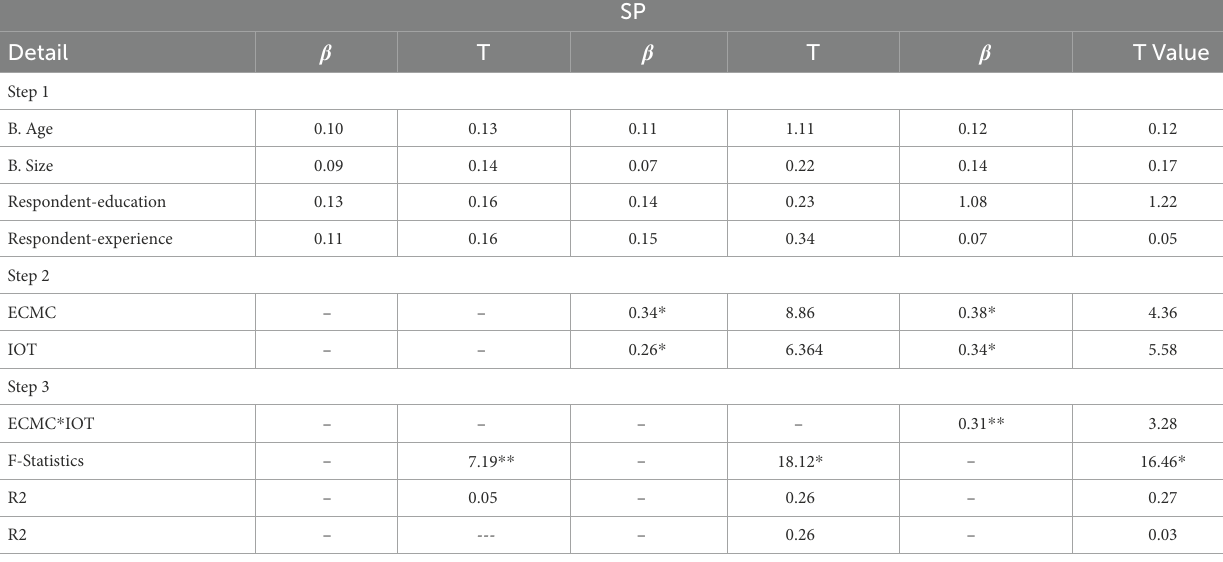
TABLE 6 Moderating effect of the internet of